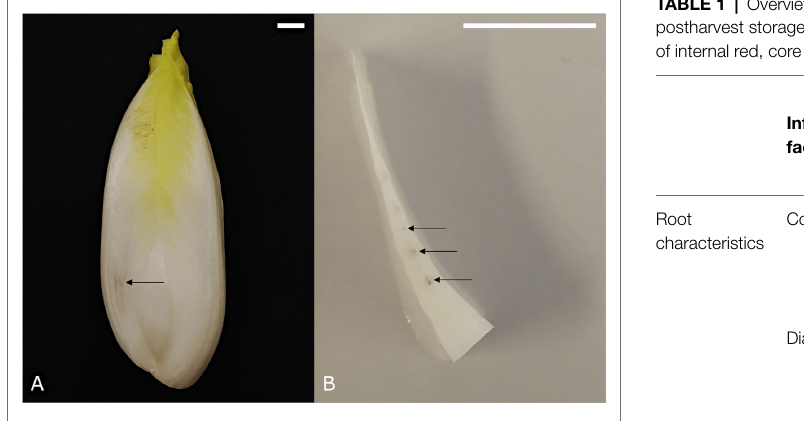
FIGURE 5 | (A) Symptoms of black discoloration of a chicon and (B) the localization of black pigment in the vascular tissue on a cross section. Scale bars represent 1 cm.